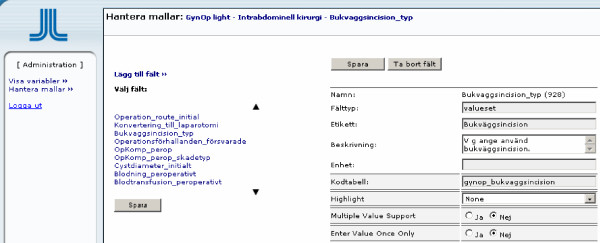
TDS administration screen.